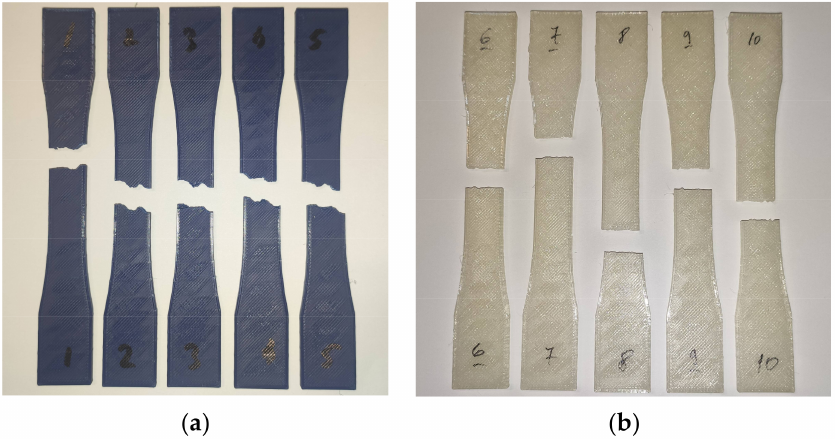
Figure 4. Fracture modes of tested parts: ( a ) PLA parts from the control group; ( b ) PETG parts from the UV-B exposure group.